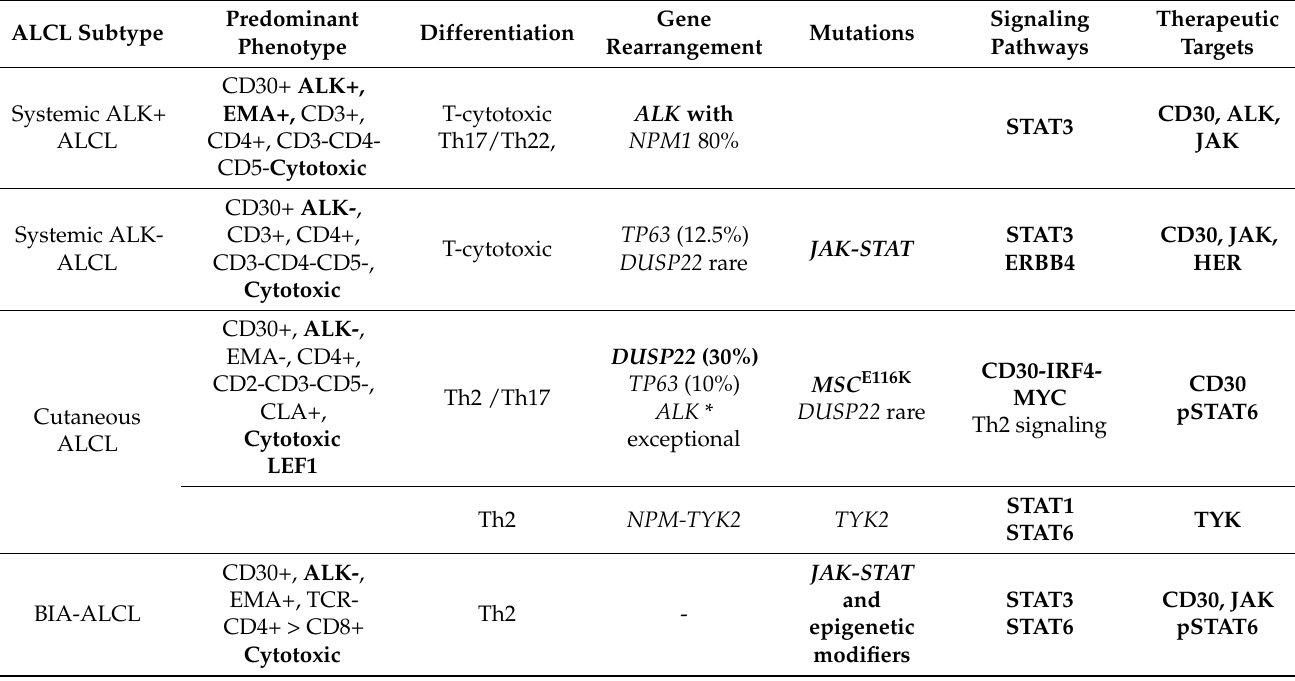
Table 2. Predominant features of the different anaplastic large cell lymphoma subtypes. ALCL, anaplastic large cell lymphoma. BIA-ALCL, breast implant-associated ALCL. * Exceptional ALK+ cutaneous ALCLs